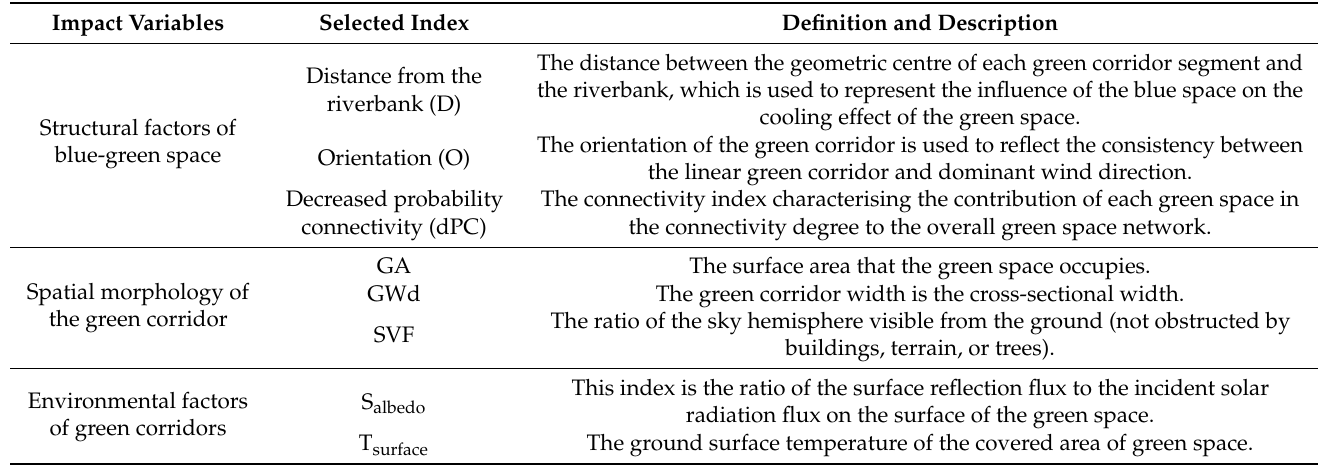
Table 1. Spatial index to describe the structure and morphology of green